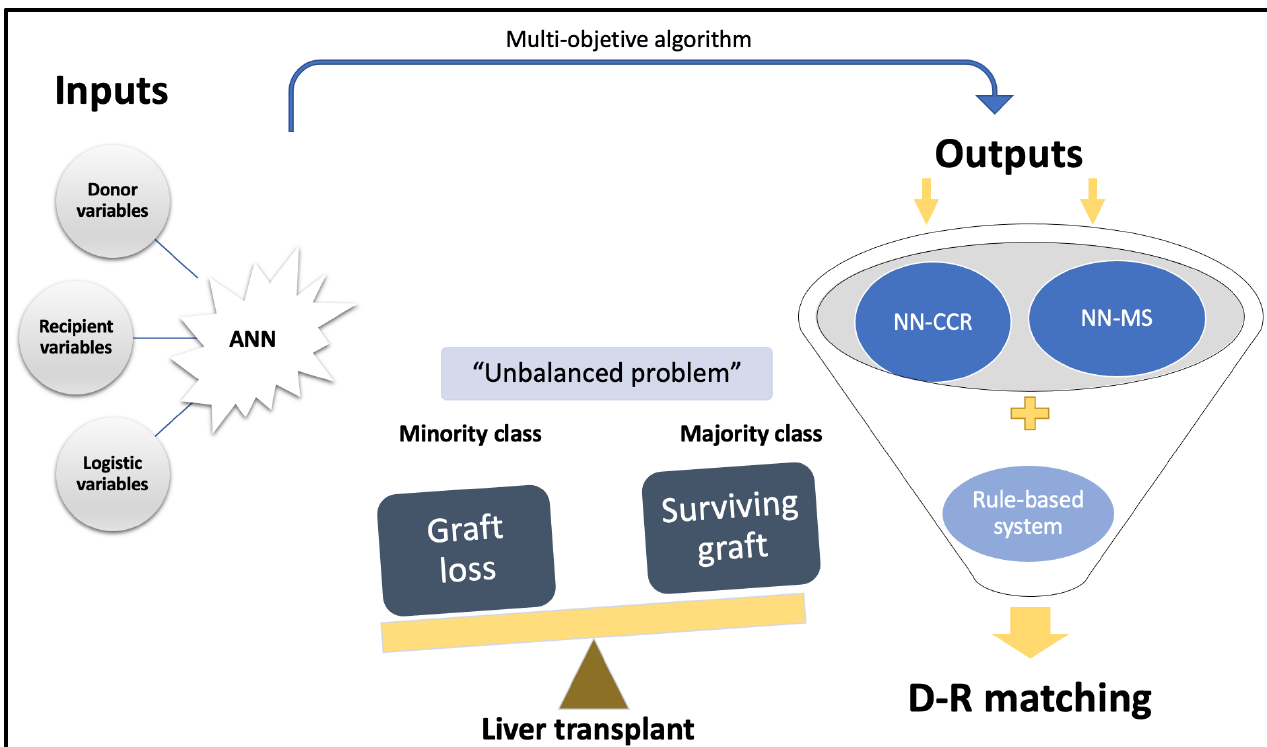
Figure 3. Diagram of an ANN-based on a multi-objective algorithm. Liver transplantation outcomes are shown as an unbalanced problem, and we classify them into the majority class (probability of surviving after liver transplantation, NN-CCR) and the minority class (probability of not surviving, NN-MS). By combining both probabilities (NN-CCR and NN-MS) based on input variables, we obtain a final D–R matching according to a rules-based system. ANN, artificial neural network; NN-CCR, neural network based on the correct classification rate or accuracy; NN-MS, neural network based on the minimum